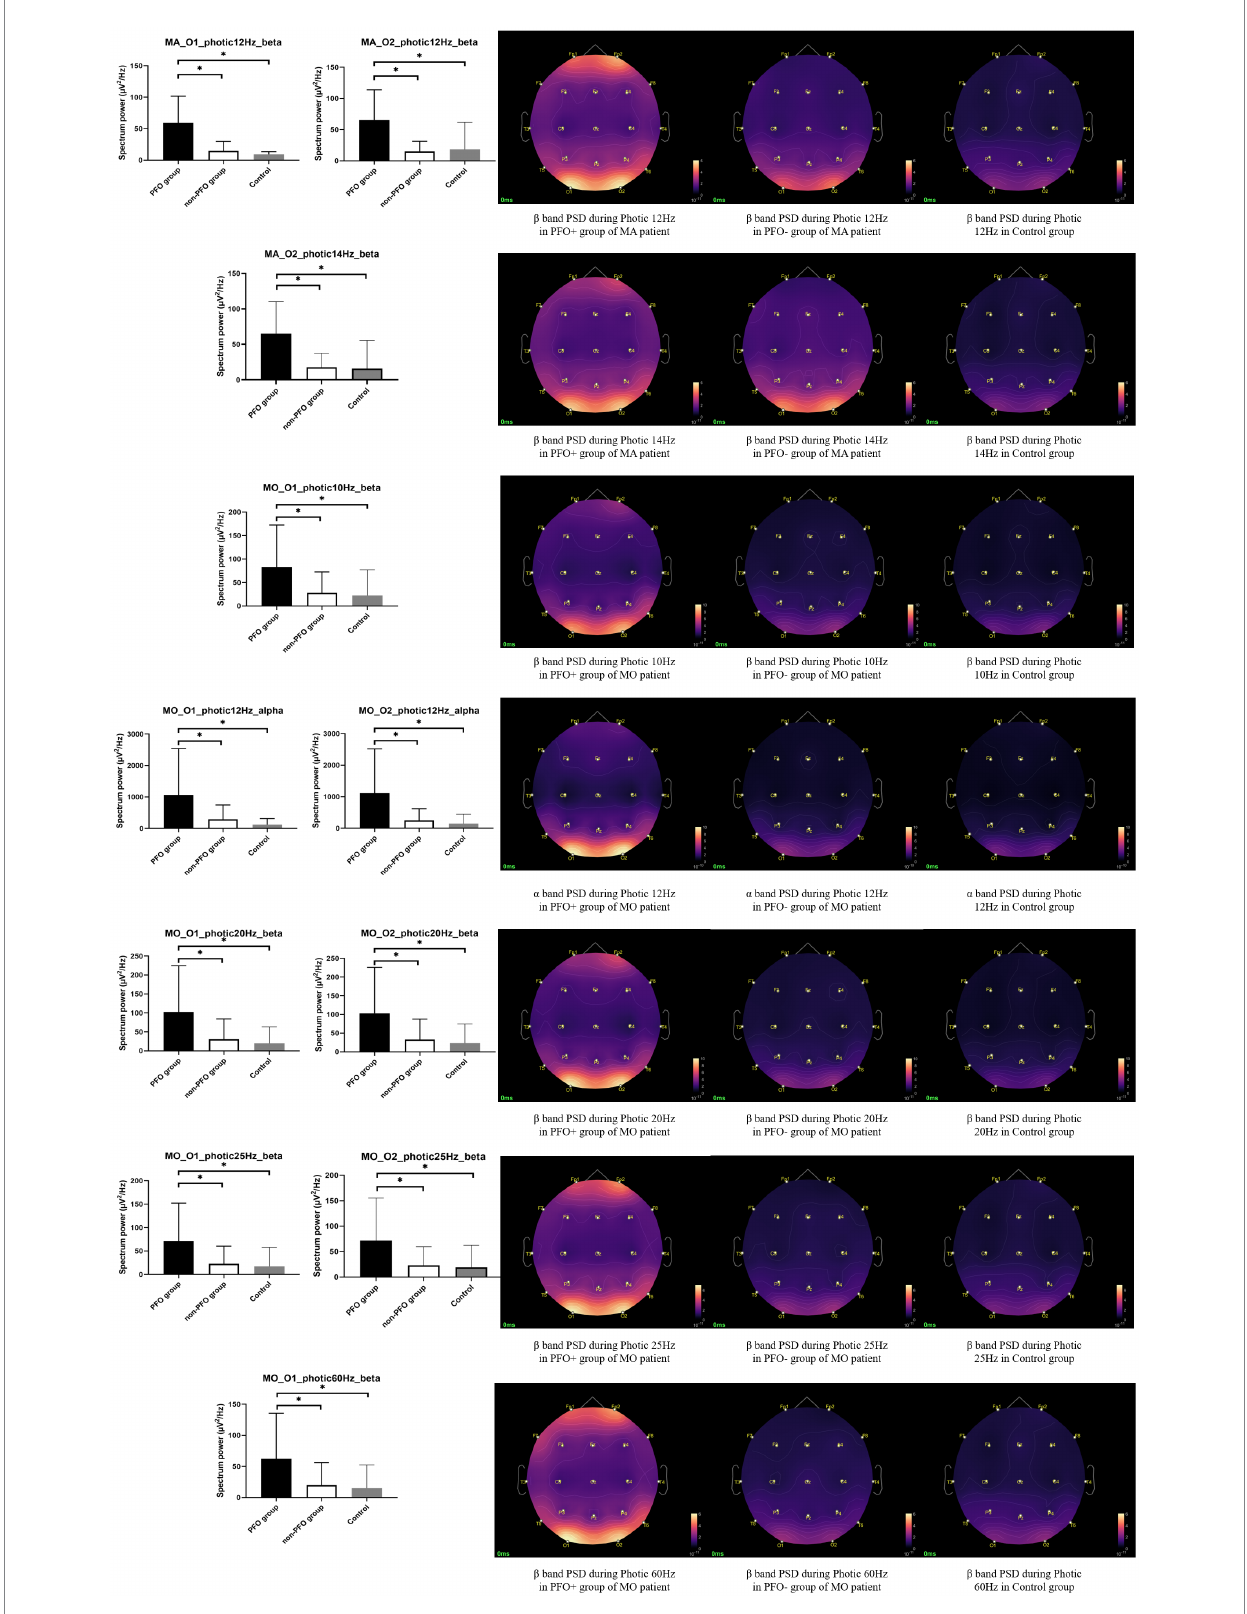
FIGURE 2 Subgroup analysis results of alpha and beta band PSD on the occipital region during photic stimulation. In migraine with aura (MA) patients, the PFO + group ( n = 11) showed an increased beta band PSD during photic stimulation at 12 and 14 Hz compared to PFO-group ( n = 7) and Control group. Whereas in MO patients, the PFO + group ( n = 24) presented higher alpha band PSD during photic stimulation at 12 Hz and higher beta band PSD during photic stimulation at 10, 20, 25, and 60 Hz. The PSD topography on the right side provides a more intuitive representation of the distinction between the two groups. * adjusted p <